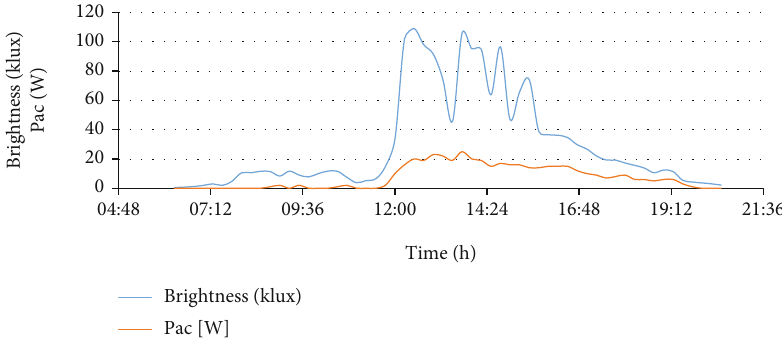
Figure 4: Time evolution of power (W) and brightness (klux) parameters. Table 1: The accuracy of the ARIMA